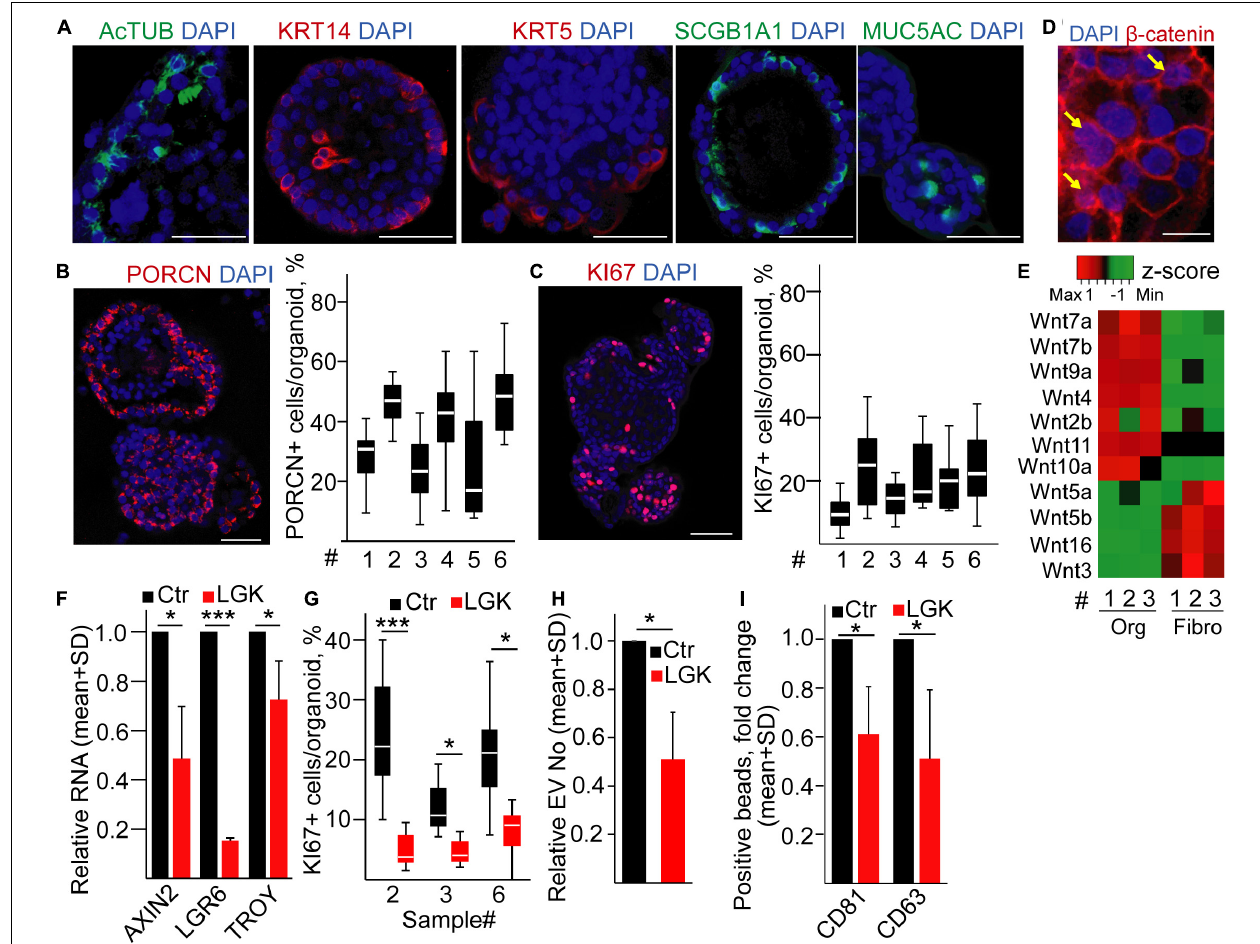
FIGURE 4 | Inhibiting PORCN results in a reduced EV secretion in human bronchiolar organoids. (A–C) Immunostaining of human bronchiolar organoids for the indicated molecules (confocal microscopic images). For panels (B,C) , quantification of the images is shown for different patient-derived organoids ( # , see Supplementary Information). (D) Immunostaining of β -catenin (confocal microscopic image). Arrows indicate the nuclear localization of β -catenin. (E) Expression profile of selected Wnt genes in the organoids and fibroblasts (RT-qPCR, matched samples were used). Results normalized to HPRT1 housekeeping were z -score transformed. Red and green colors indicate higher and lower RNA levels, respectively. (F) Relative RNA level of AXIN2 , LGR6 , and TROY after treating organoids with LGK974 (RT-qPCR, n = 3). Data were normalized to HPRT1 housekeeping and then compared to untreated samples (Ctr). (G) The percentage of KI67+ cells in the organoids with/without treatment with the PORCN inhibitor (confocal microscopic images were quantified). (H) EV number change in the presence of LGK974 (NTA, n = 4). Data normalized to 10 6 cells were compared to the untreated control (Ctr). (I) Fold change in the percentage of anti-CD63 and anti-CD81-coated beads incubated in the conditioned medium derived from untreated (Ctr) or treated (LGK) organoids and detected with anti-CD63 or anti-CD81 antibody, respectively. Note that medium control (without EVs) was always < 1%. All data were normalized to 10 6 cells before comparisons (flow cytometry, n = 5). One-sample t -test after log10 transformation of fold change data (F,H,I) or Mann–Whitney test for within-sample comparisons (G) was used with * p < 0.05 and *** p < 0.005. Scale bars: 50 µ m (A–C) or 20 µ m (D)